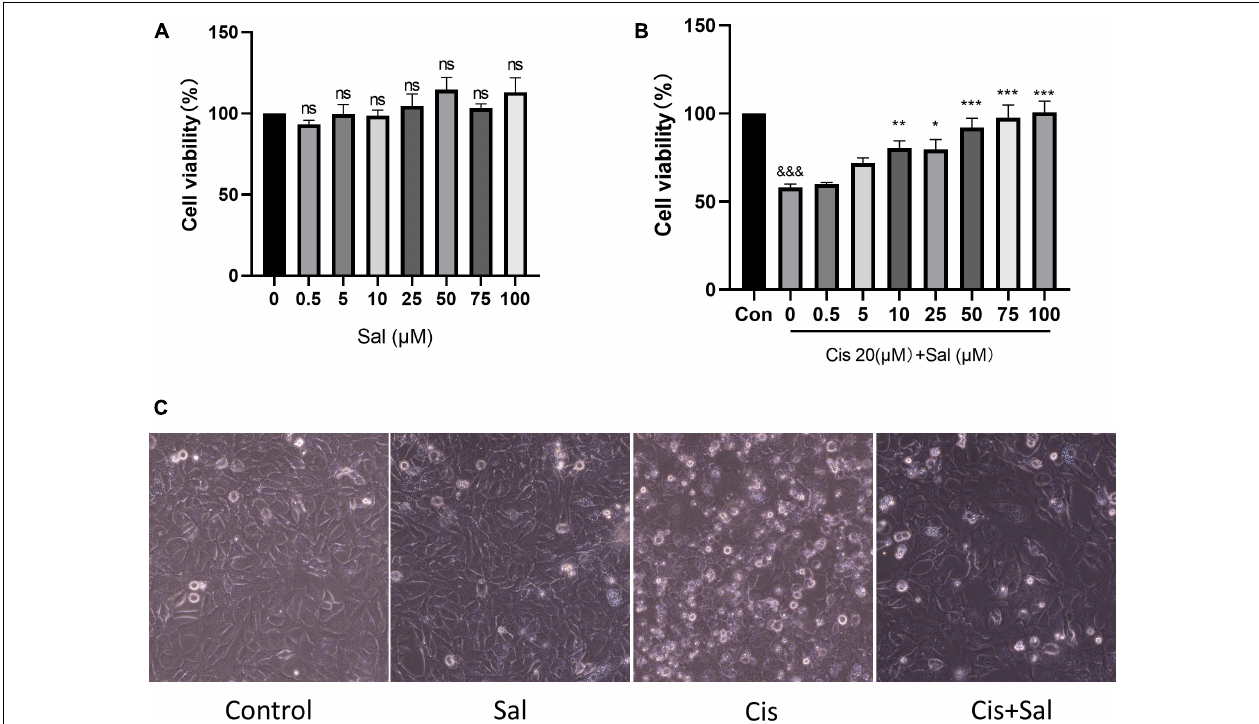
FIGURE 1 | Sal enhances the viability of HEI-OC1 cells after cisplatin damage. (A) HEI-OC1 cells were treated with different Sal concentrations for 24 h. (B) HEI-OC1 cells were pretreated with or without different Sal concentrations (0–100 µ M) for 4 h, followed by 20 µ M co-treatment for 24 h except for those in the control group. (C) Image of HEI-OC1 cells cultured with different Sal or cisplatin concentrations. Scale bars = 100 µ m. Cell viability was measured using the CCK-8 assay. Values are presented as mean ± SEM from independent experiments. * P < 0.05, ** P < 0.01, and *** P < 0.001 vs. the control group; &&& P < 0.001 vs. the cisplatin group. ns, no statistical difference; Sal, salubrinal; Cis, cisplatin; con, control.